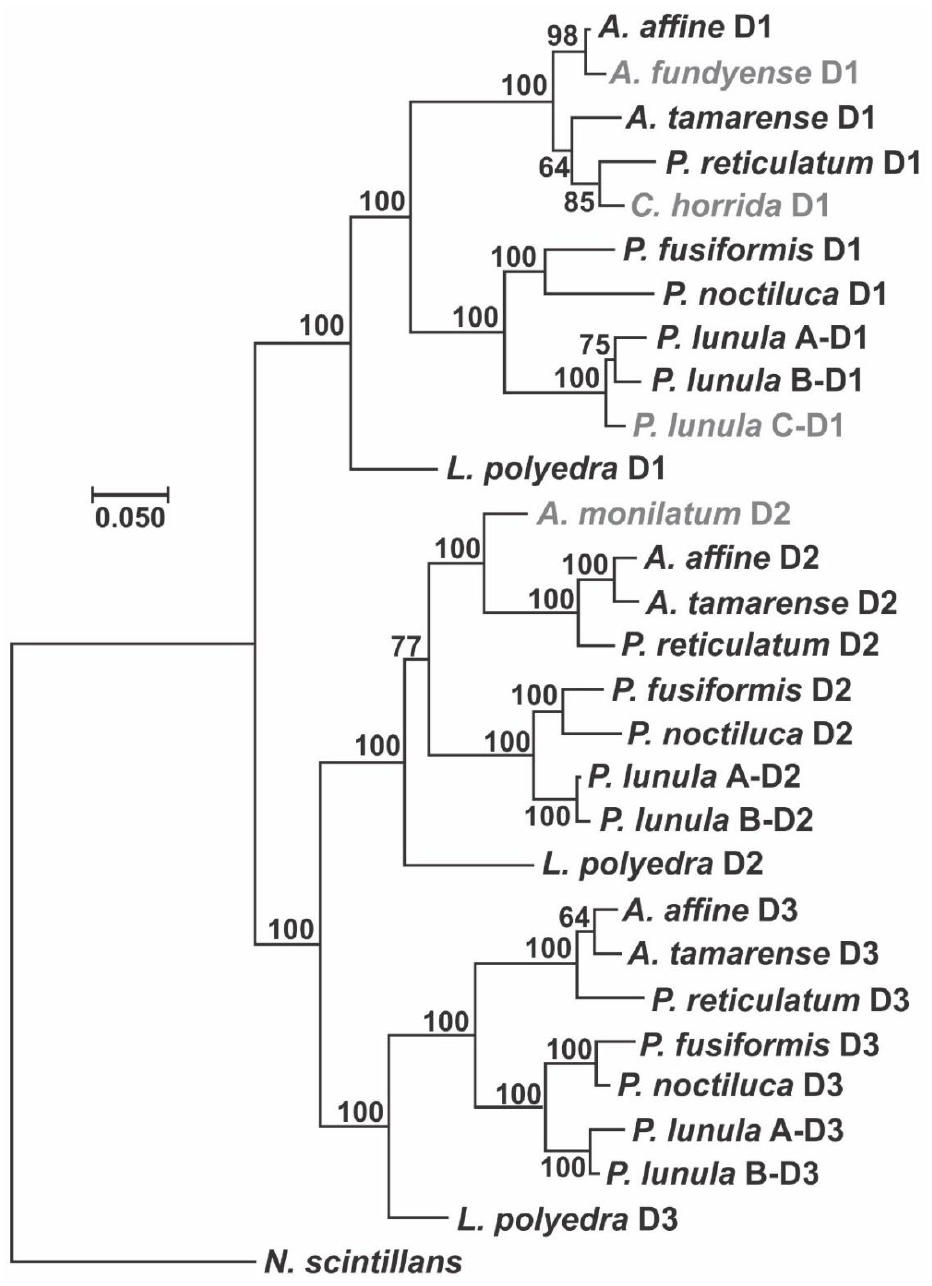
Figure 4. Molecular Phylogenetic analysis by a Bayesian method, showing the evolutionary pattern of the three catalytic domains in the species of dinoflagellates with protein sequences available, using the sole catalytic domain from N. scintillans as outgroup. The percentage of trees in which the associated taxa clustered together is shown next to the branches. There was a total of 297 positions in the final dataset and the tree is drawn to scale, with branch lengths measured in the number of substitutions per site.